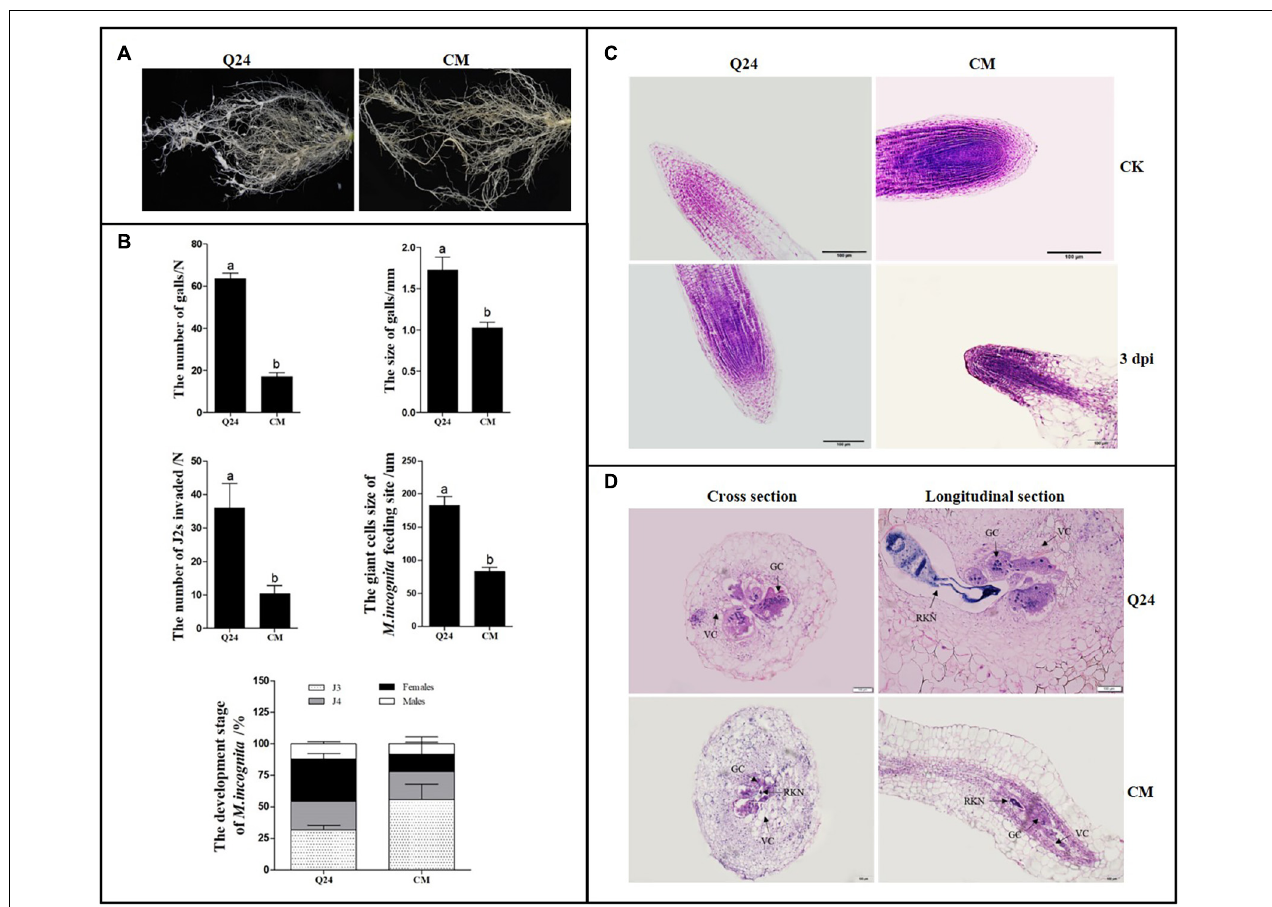
FIGURE 1 | Symptom development and growth on susceptible Q24 and resistant CM plants. (A) The roots of Q24 and CM at 25 dpi; (B) comparison of disease indexes of Q24 and CM at 25 dpi. Error bars indicate the standard error of the means. Different letters on the bars “a, b, c” indicate statistically significant means between Q24 and CM at 25 dpi at P < 0.05 based on Duncan’s t -tests; (C) root tips of Q24 and CM at 3 dpi and the corresponding controls; (D) cross and longitudinal sections of nematode feeding sites (NFS) inside the galls at 15 dpi. GC, giant cell; VC, vacant cell; V,